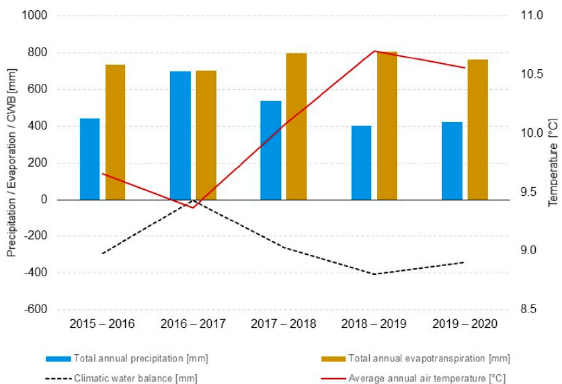
Figure 1. Meteorological conditions during the five-year observation